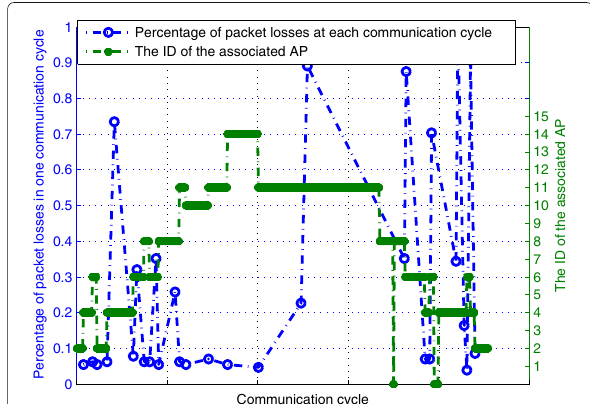
Fig. 7 Relationships between percentage of packet losses in a communication cycle and the associated AP at each communication cycle when interference exists